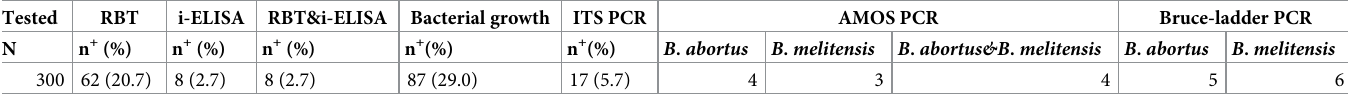
RBT: Rose Bengal Test, i-ELISA: indirect enzyme-linked immunosorbent assay, ITS-PCR: the 16S-23S ribosomal interspacer region PCR, AMOS PCR: B . abortus , B . melitensis , B . ovis , and B . suis PCR.